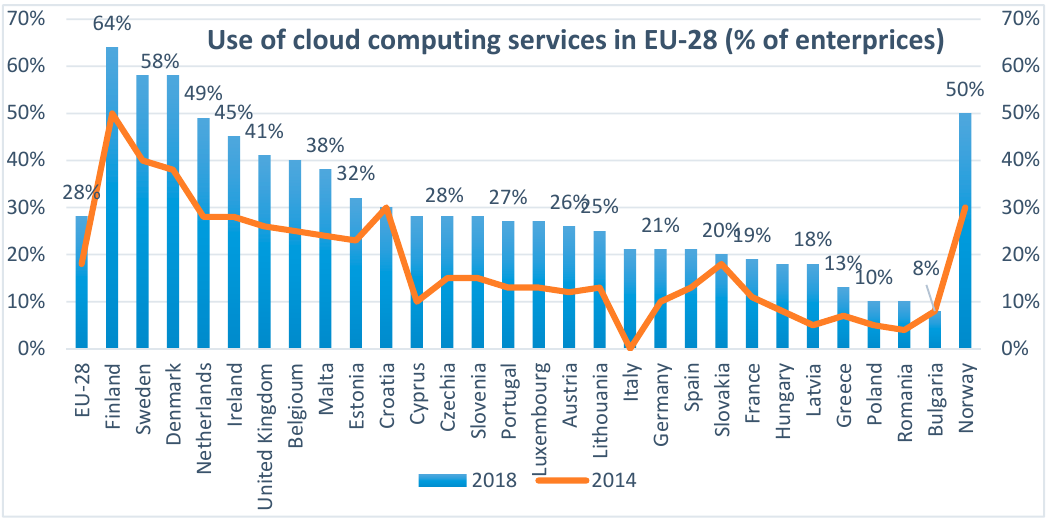
Figure 1. cloud computing Usage in EU-28 enterprises (created by the authors according to Eurostat Figure 1. Cloud computing Usage in EU-28 enterprises (created by the authors according to [18]). Eurostat